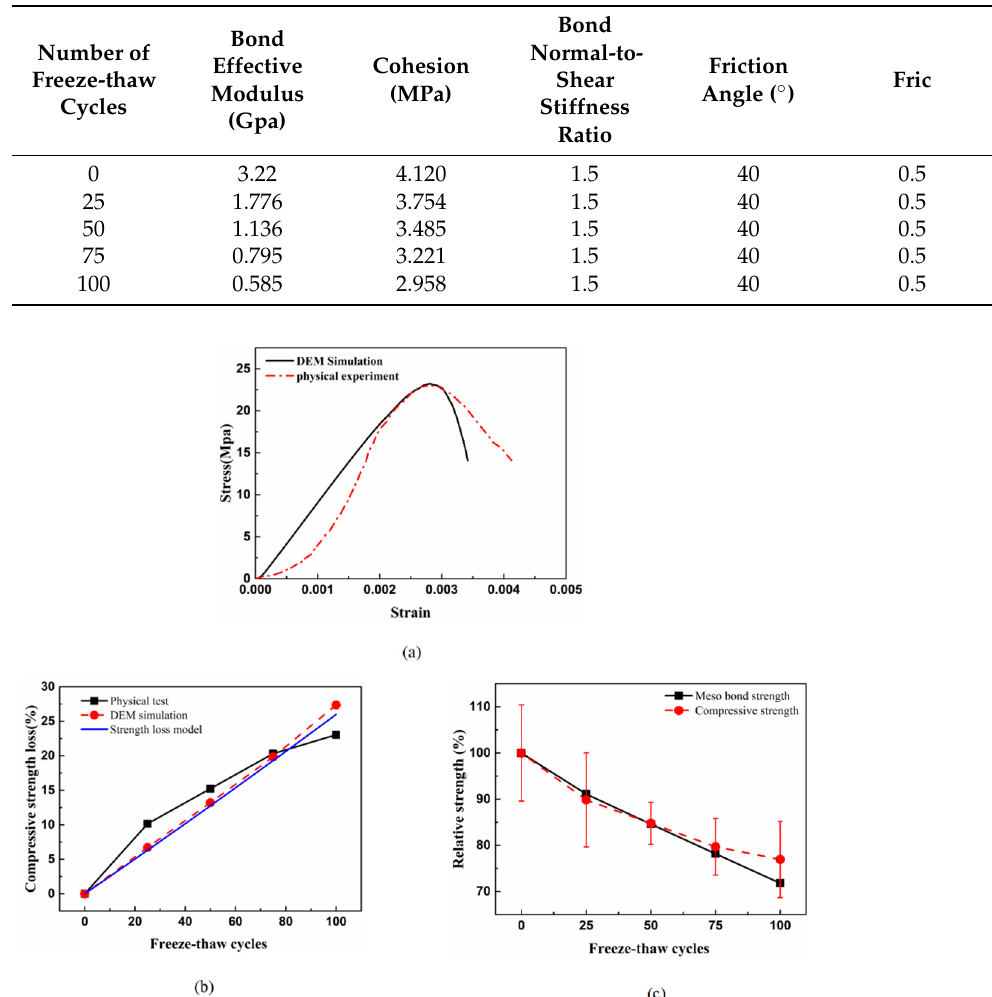
Table 5. Changes of meso parameters of model under freeze-thaw cycles.